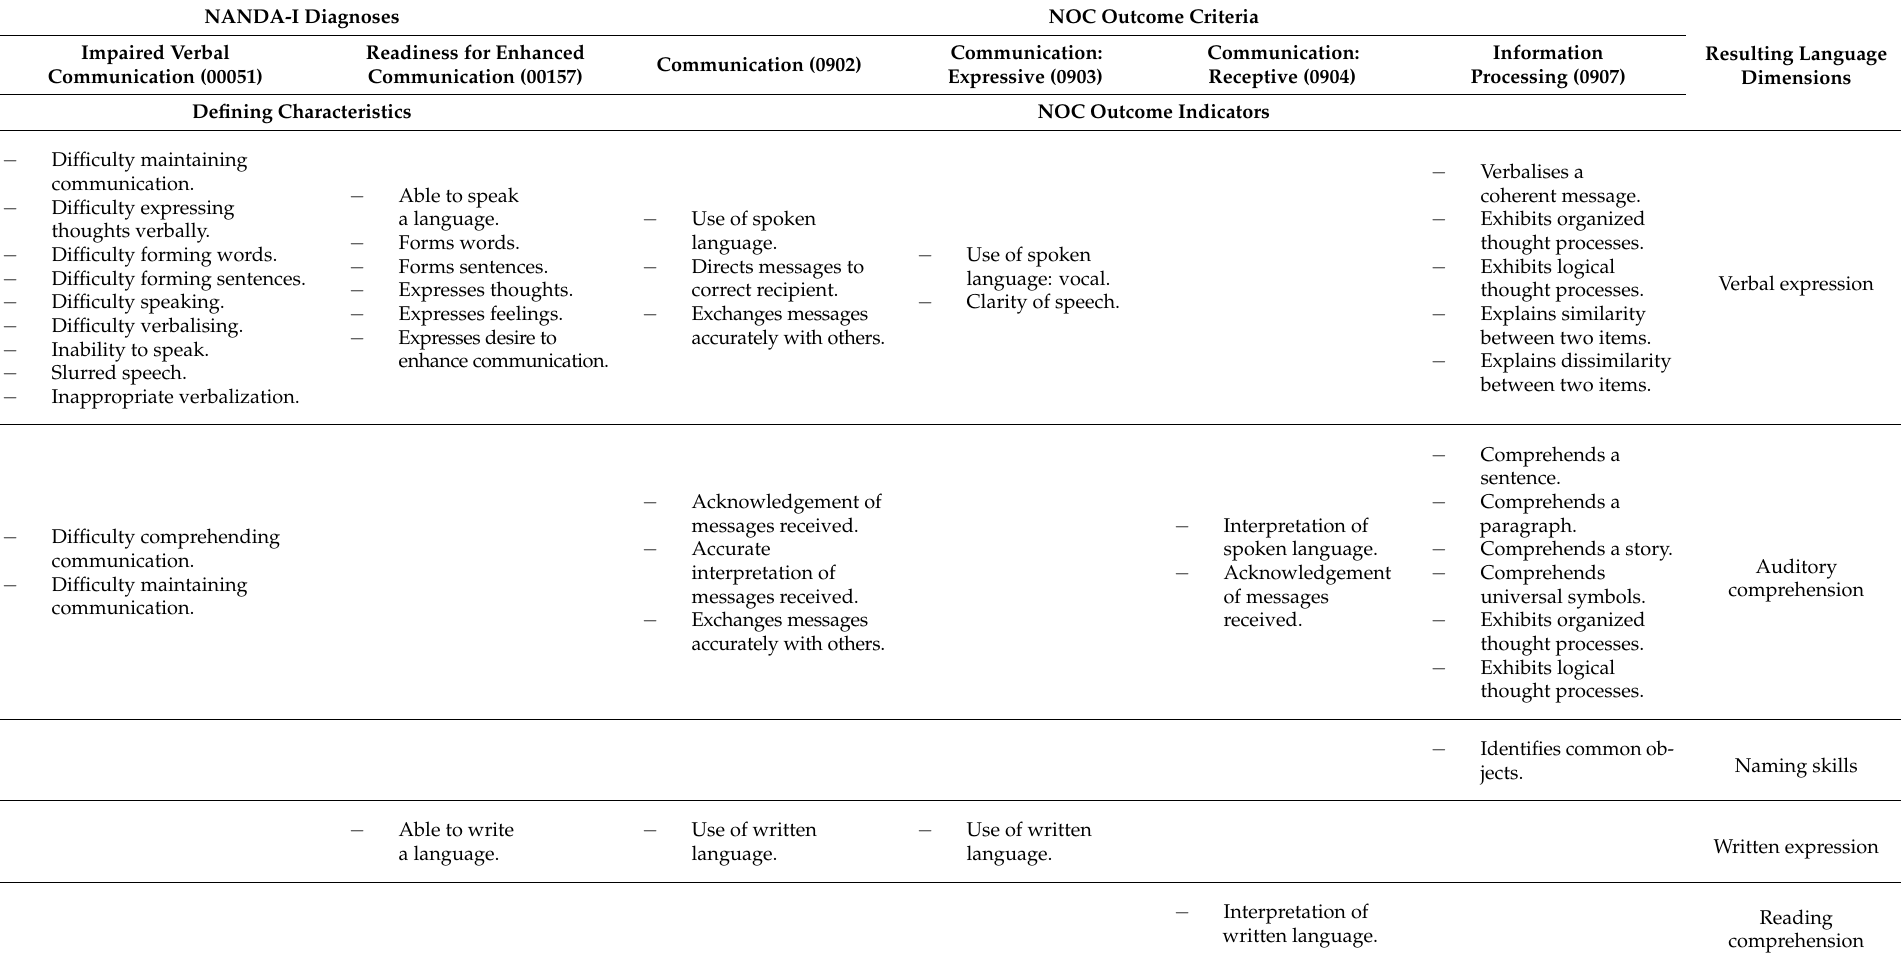
Table 1. Defining characteristics of the NANDA-I diagnoses and the NOC outcome indicators distributed by language